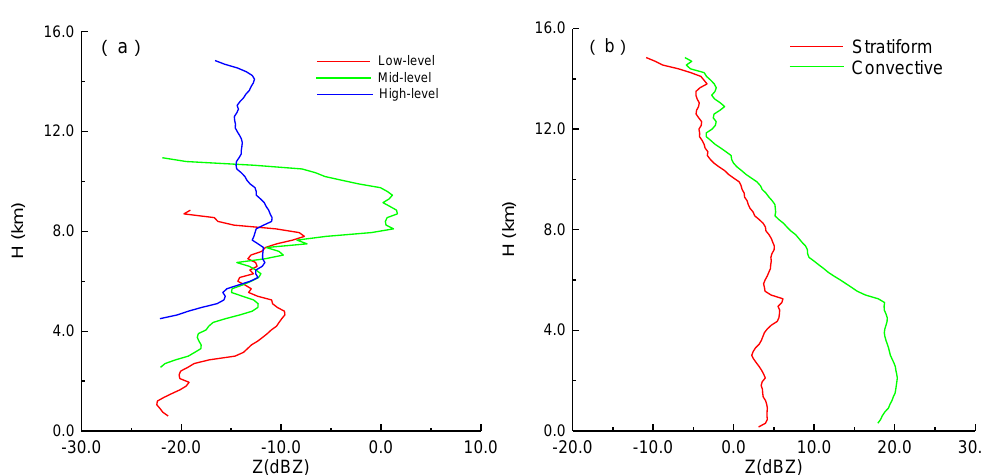
Figure 19. Vertical profiles of averaged reflectivity for ( a ) non-precipitating clouds (low-, mid- and high-level) and ( b ) precipitating clouds (convective and stratiform).